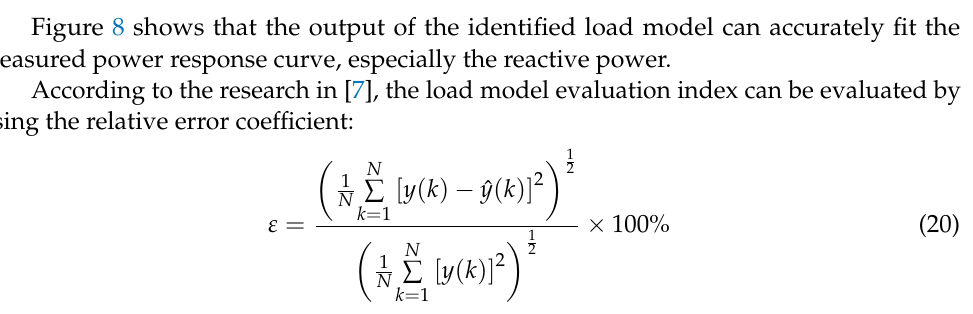
Figure 8. Fitting curve between measured data and calculated data.